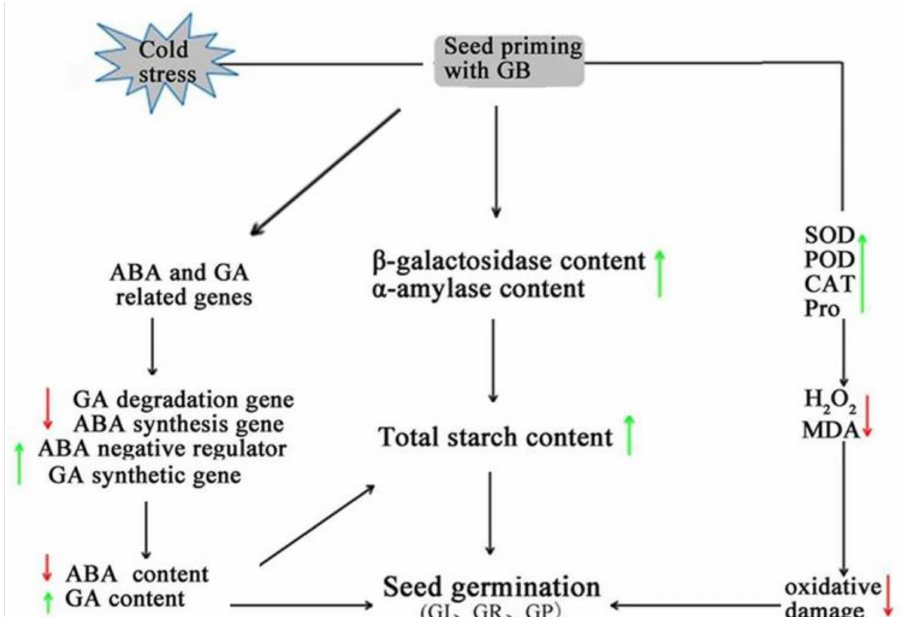
Figure 7. Schematic diagram of the cold tolerance of tomato seeds pretreated with betaine. Low- temperature stress can regulate the expression of plant hormone signal transduction genes, which induce cold tolerance mainly through the expression of plant hormone content and ROS clearance- related genes. The red arrow means down, and the green arrow means